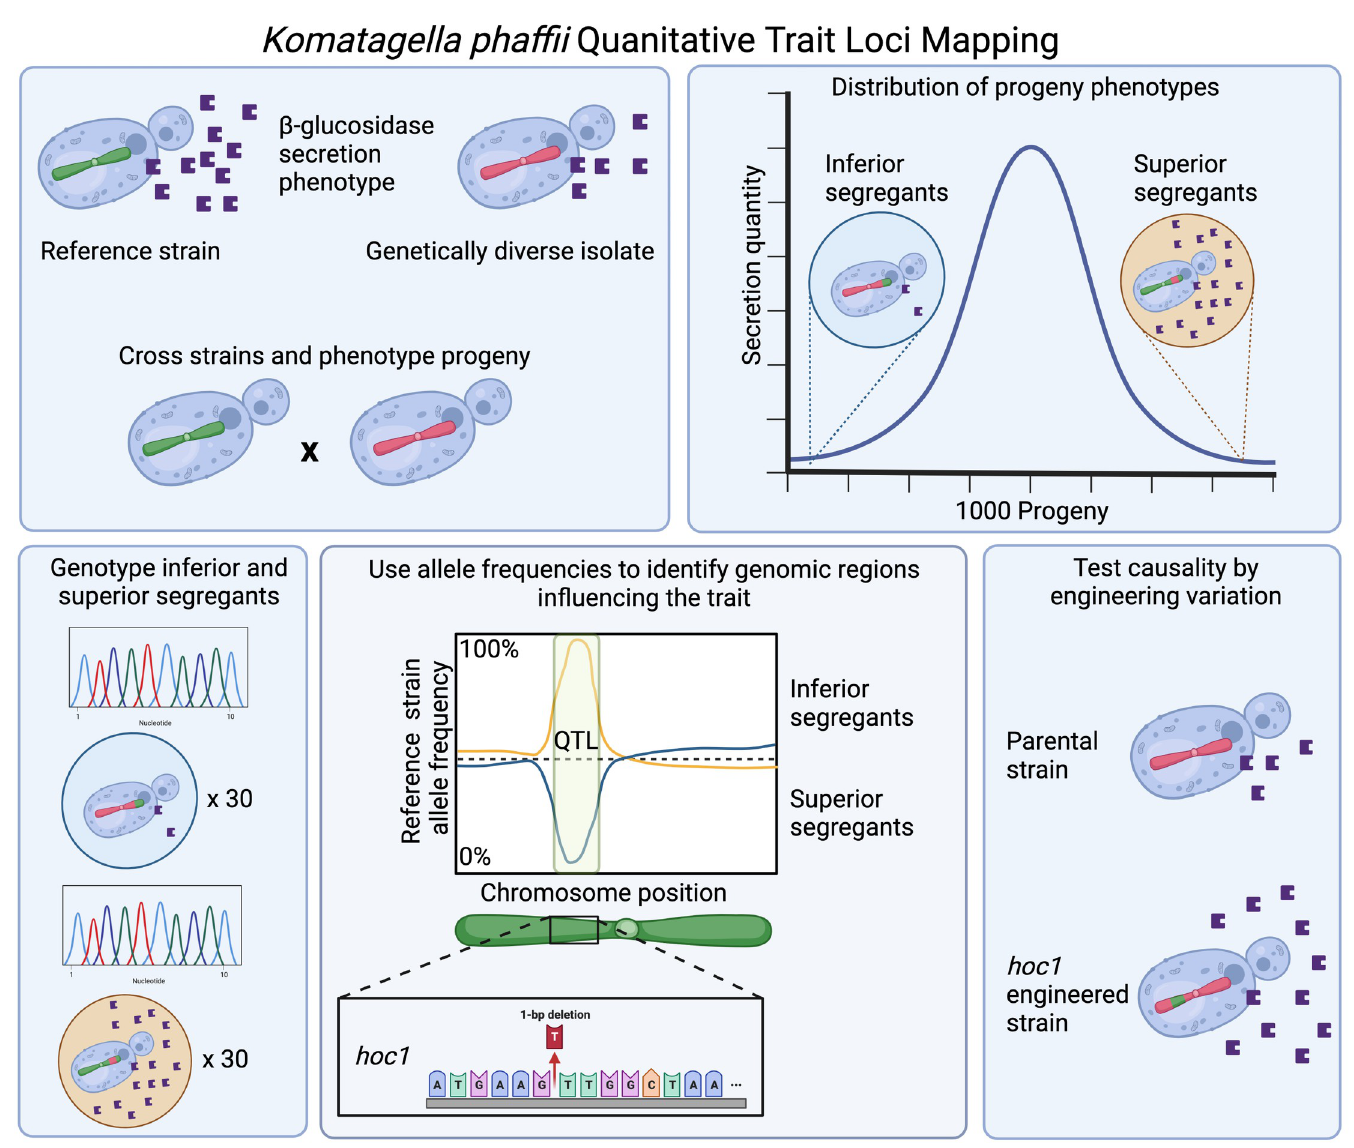
Fig 1. Schematic representation for mapping protein secretion quantitative trait loci. The reference strain of K . phaffii and a genetically diverse isolate differ in the secretion quantity of a heterologous protein, β -glucosidase. The authors crossed the 2 strains and isolated 1,000 recombinant haploid progeny (segregants). They then measured β -glucosidase secretion in each of the 1,000 segregants and selected those segregants with extreme phenotypes for whole-genome sequencing. This enabled the authors to compute the frequency of each parental allele in inferior and superior segregants at variant sites across the genome. They identified QTL as regions at which allele frequencies diverged between inferior and superior segregants. Sequence variants in candidate genes within the QTL were engineered into the parental strain to test whether they caused differences in β -glucosidase secretion. Figure created with